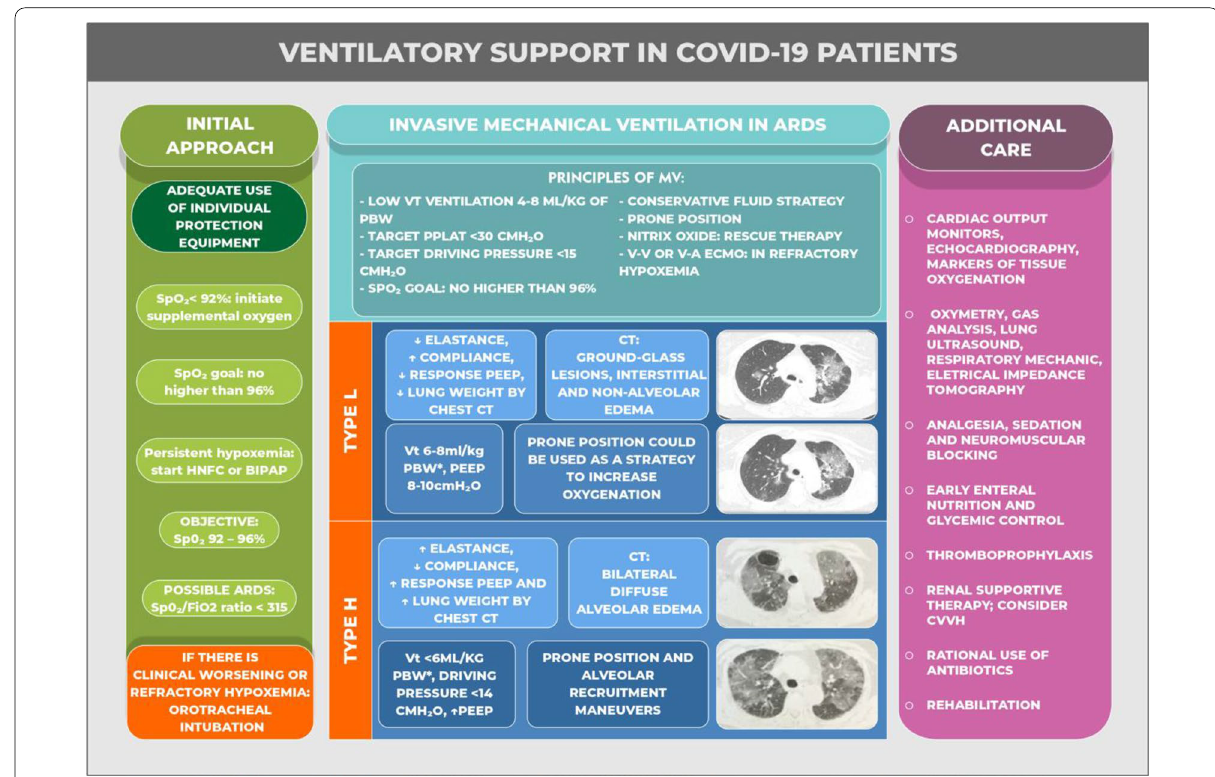
Fig. 2 Ventilatory support in COVID‑19 patients. PBW predicted body weight, ARDS acute respiratory distress syndrome, BNP brain natriuretic peptide, CPAP continuous positive airways pressure, CT computerized tomography, CVVH continuous venovenous hemofiltration, CRP C‑reactive protein, ECMO extracorporeal membrane oxygenation, LDH lactic dehydrogenase, PEEP positive end‑expiratory pressure, PPlat plateau pressure, HNFC high‑flow nasal cannulas, NIV non‑invasive ventilation, PEEP positive end‑expiratory pressure, SpO2 peripheral O2 saturation, PaO2 partial pressure of oxygen, Vt tidal volume, V-V venovenous, V-A